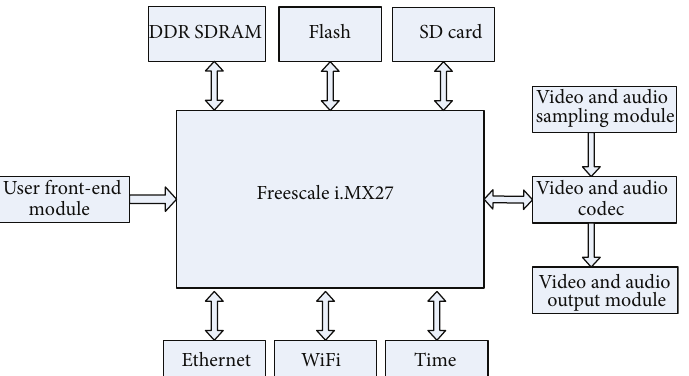
Figure 2: The block diagram of the multimedia terminal.